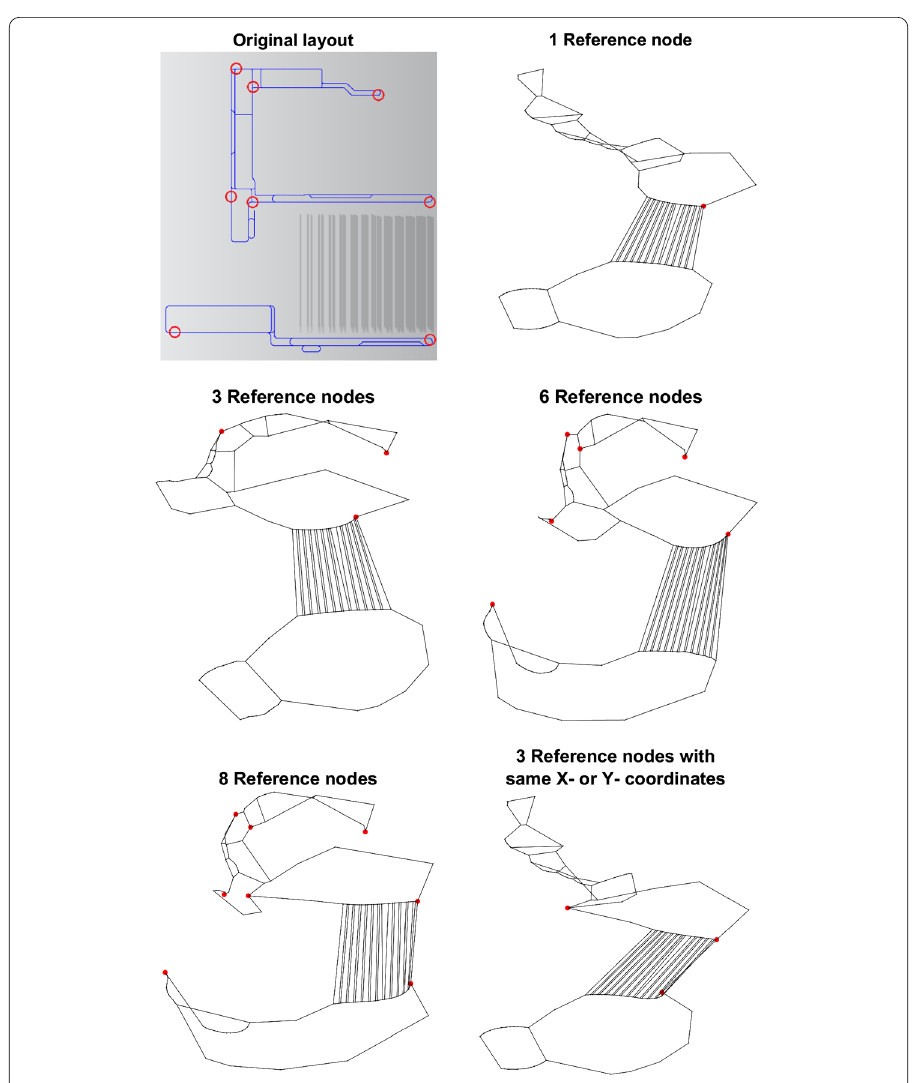
Figure 22 Comparison of the optimized graphs with different numbers of reference nodes